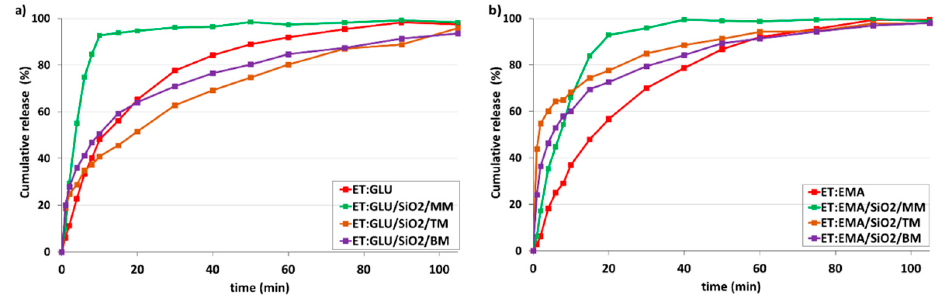
Figure 14. In vitro dissolution profiles of ( a ) ET in ET:GLU cocrystal and ET:GLU cocrystal loaded in/on silica SiO 2 , ( b ) ET in ET:EMA cocrystal and ET:EMA cocrystal loaded in/on silica SiO 2 . Samples of cocrystals loaded in/on silica SiO 2 were prepared by three methods as described in legend. Simulated gastric fluid without pepsin (SGFsp) was used as a dissolution medium. The estimated error in measurements was found to be +/ −